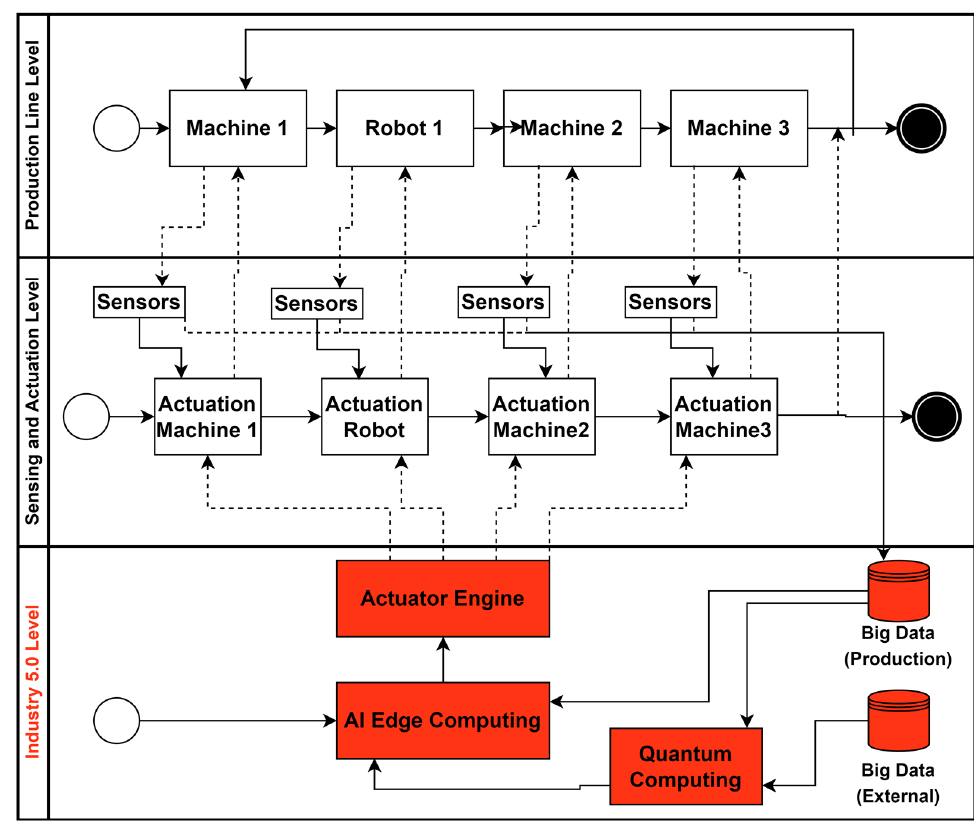
Figure 4. BPMN process modelling a simpli fi cation of the complex network of Figure